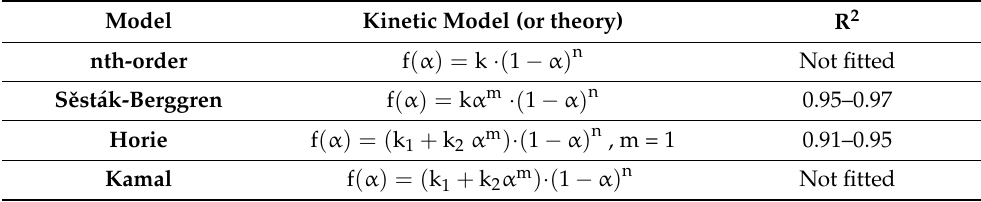
Table 1. Common kinetic models for the cooking